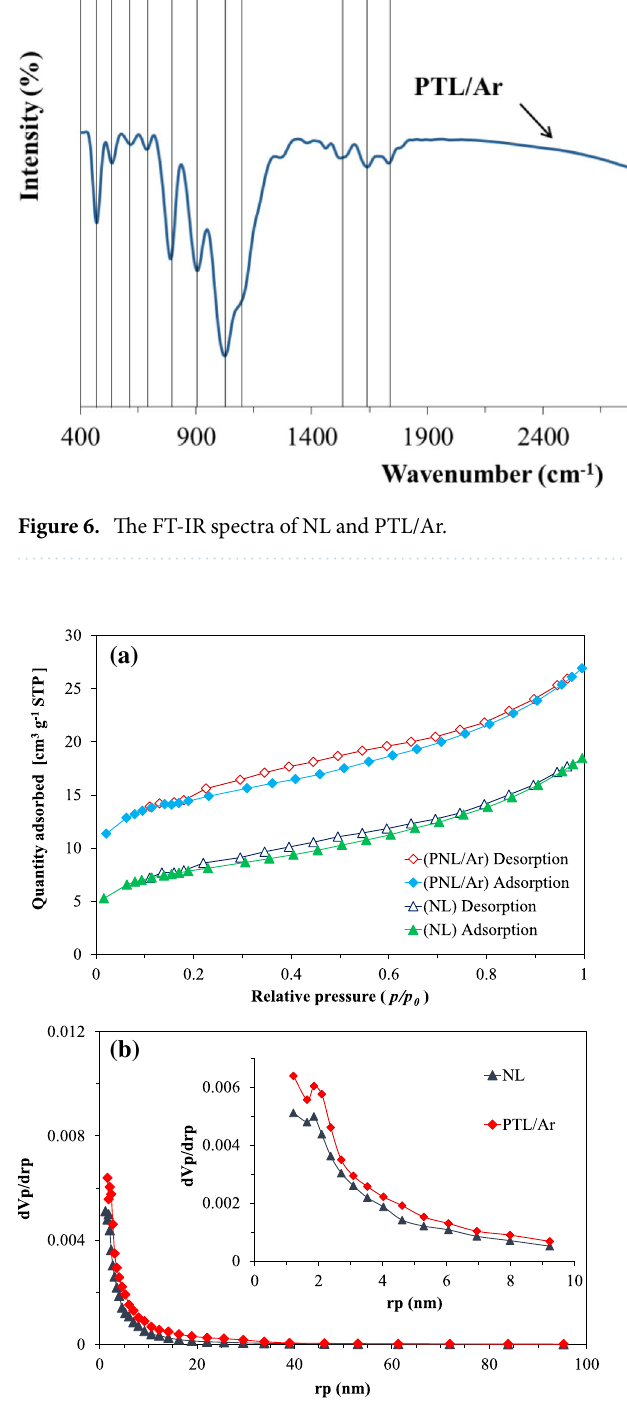
Figure 7. The nitrogen adsorption/desorption isotherms ( a ) and pore size distribution for NL and PTL/Ar ( b